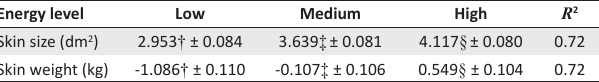
TABLE 6: A comparison of the least square means (±SE) of the natural logarithms of the slope of skin size and weight regressed against the natural logarithm of empty body protein weight as adjusted for intercept.